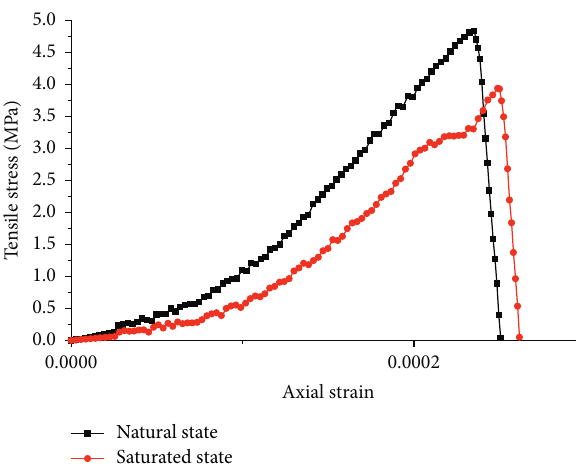
Figure 6: Tensile stress-strain curves for two water content